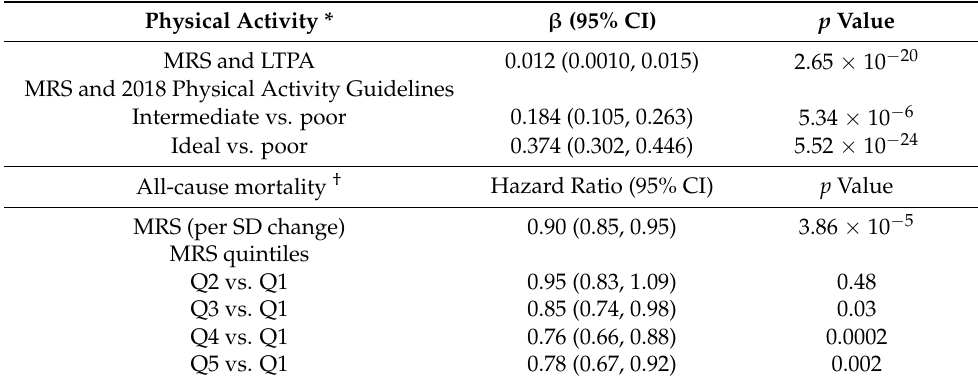
Table 2. Associations between the standardized metabolite risk score (MRS), moderate-to-vigorous- intensity leisure-time physical activity (LTPA) and incident all-cause mortality.